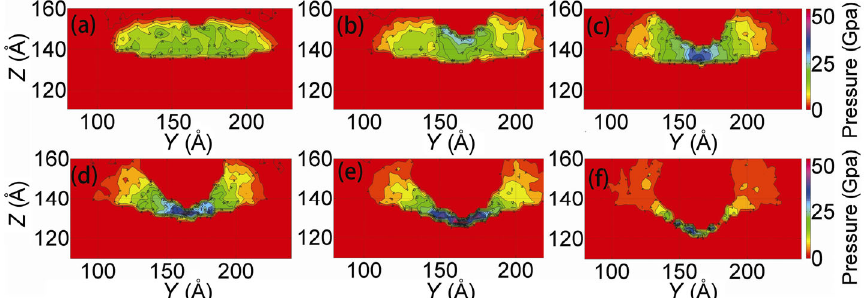
Fig. 11 Pressure distribution of water film confined at different moments under Pos150. Stage_I, Stage_II, and Stage_III range from 0–3,750 fs, 3,750–4,100 fs, and 4,100–4,900 fs, respectively. (a) 3,750 fs; (b) 3,900 fs; (c) 4,100 fs; (d) 4,300 fs; (e) 4,500 fs; (f) 4,900 fs.